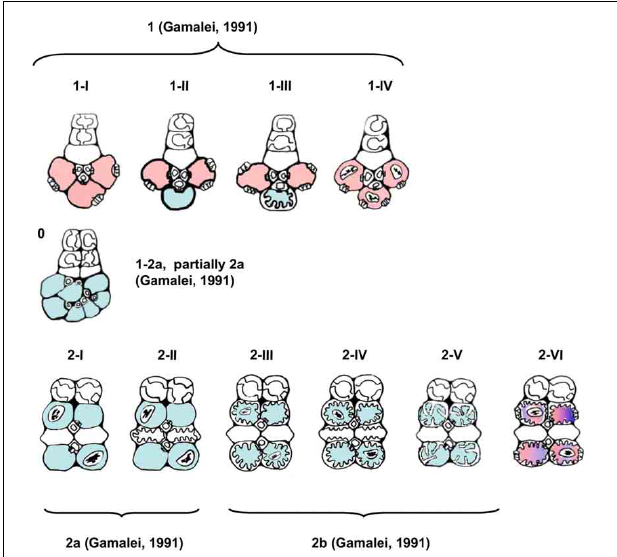
FIGURE 3 | Schematic presentation of the structural types and subtypes of minor vein phloem. Absence of plasmodesmal fields at the companion cell/bundle sheath interface is designated by blue, and the presence—by red color; in the types where companion cells could never be shown to contain chloroplasts, plastids are not depicted. Classification into four types according to Gamalei (1991) is shown for reference.